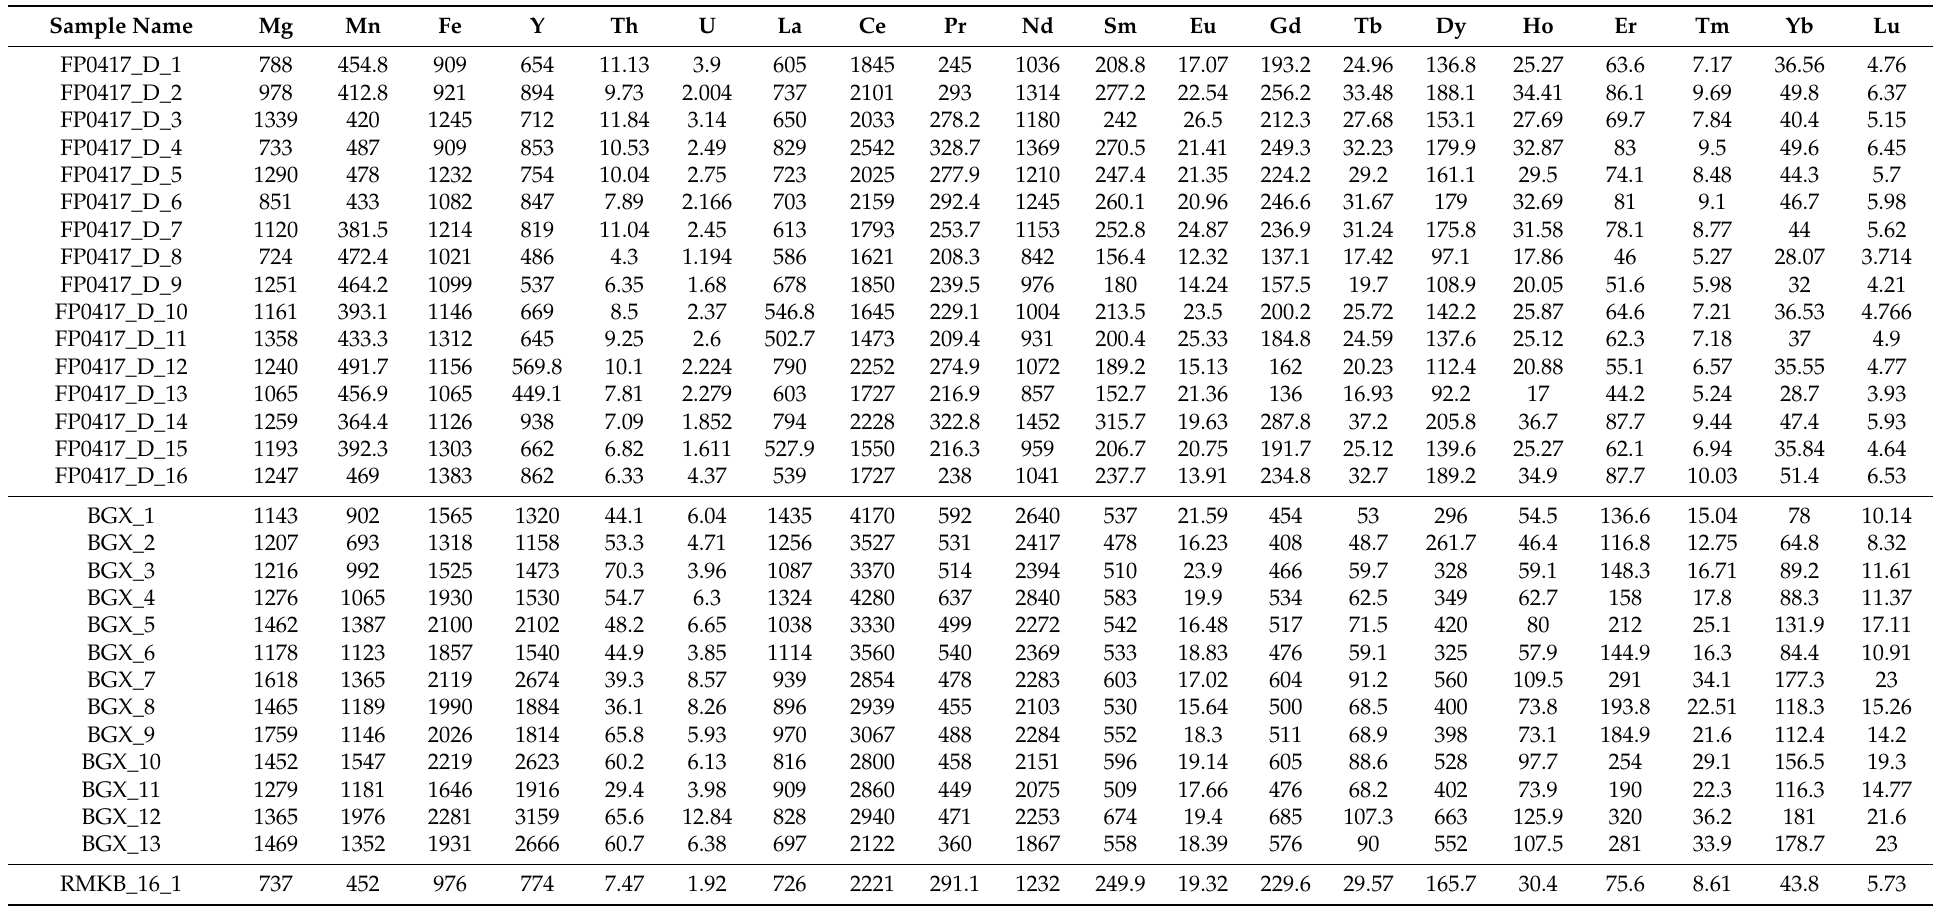
Table A2. Results from the LA-ICP-MS analyses used as the test set. All elemental abundances are given in